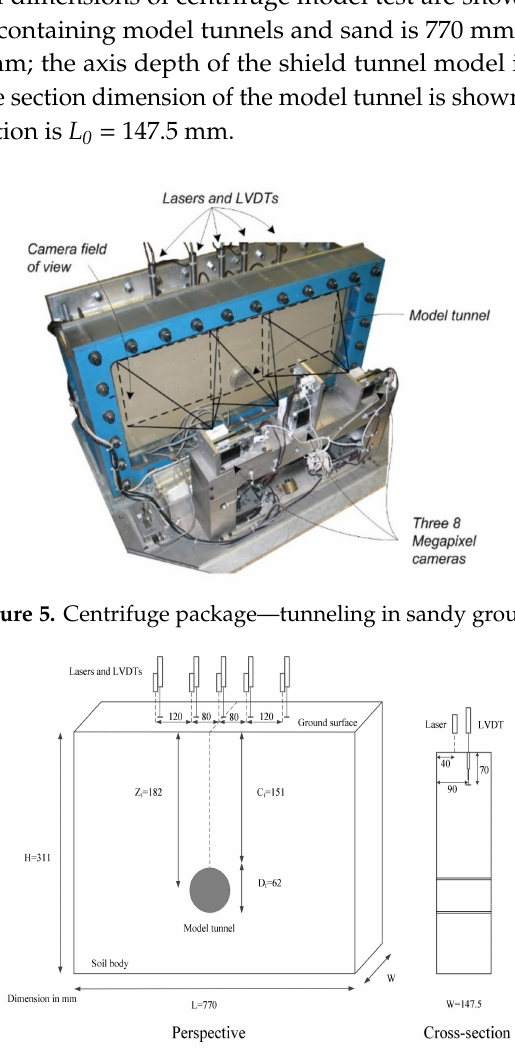
Figure 6. Centrifuge package schematic where LVDTs (linear variable di ff erential transformers) were used to measure vertical sub-surface soil displacements at the same locations as the lasers. Cameras were used to capture images of the soil body during tests for